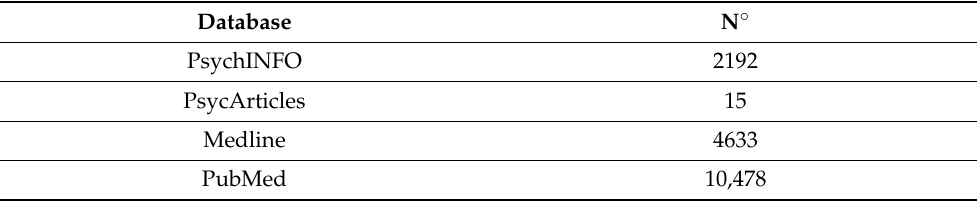
Table 1. Research